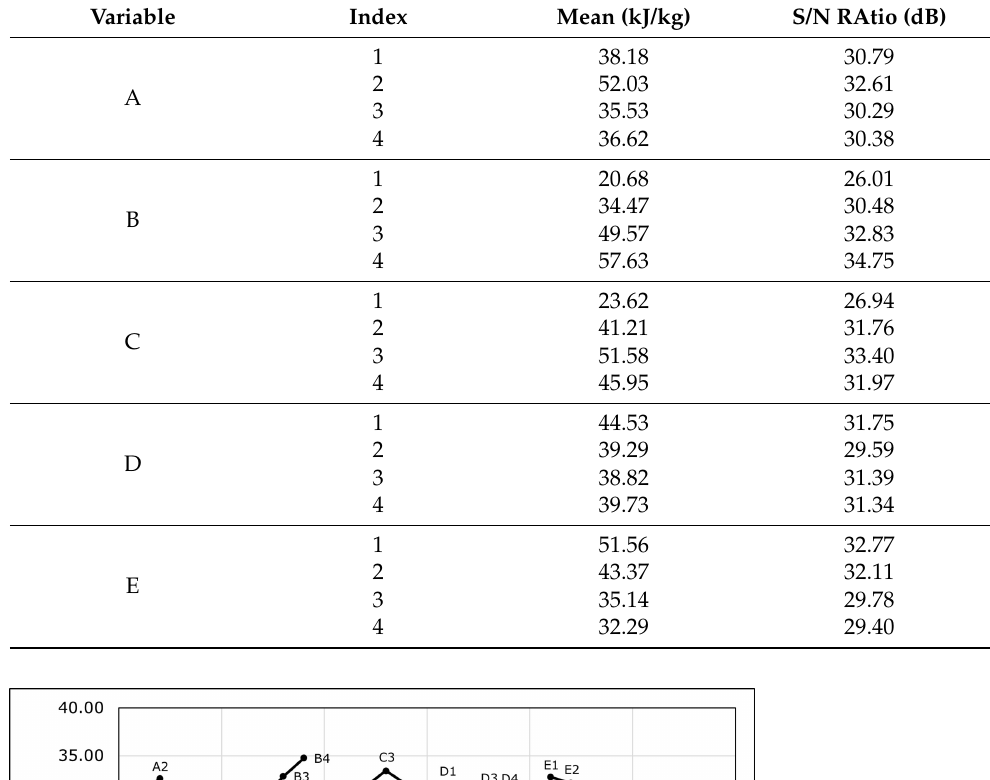
Table 6. Average and S/N Ratio for Each Control Factor and Level.